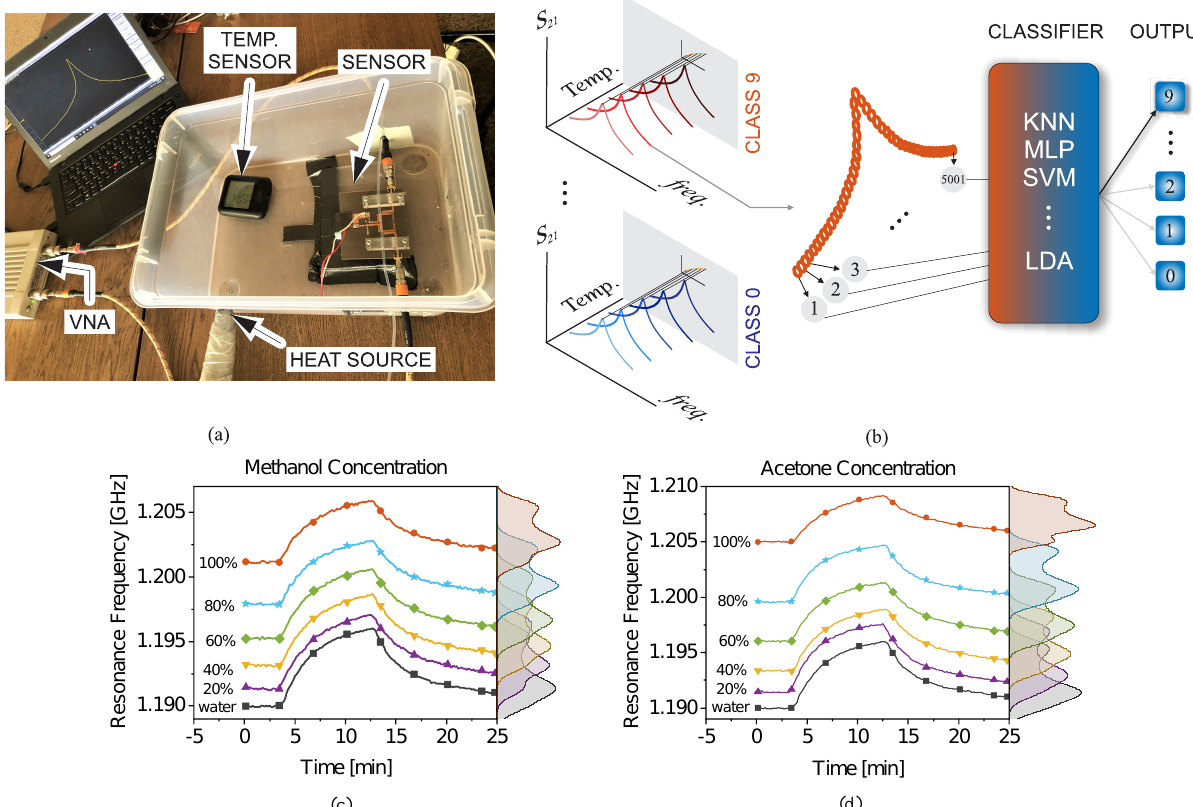
Figure 45. Temperature modulation of the active sensor loaded with MUT. ( a ) sensing setup with sealed box to control the humidity; ( b ) schematic of the proposed architecture using machine learning for classification. Measured sensor response overlap for various concentrations of water in ( c ) methanol and ( d ) acetone undergoing temperature cycle ( 25 → 55 ◦ ) . Reprinted with permission from Ref.